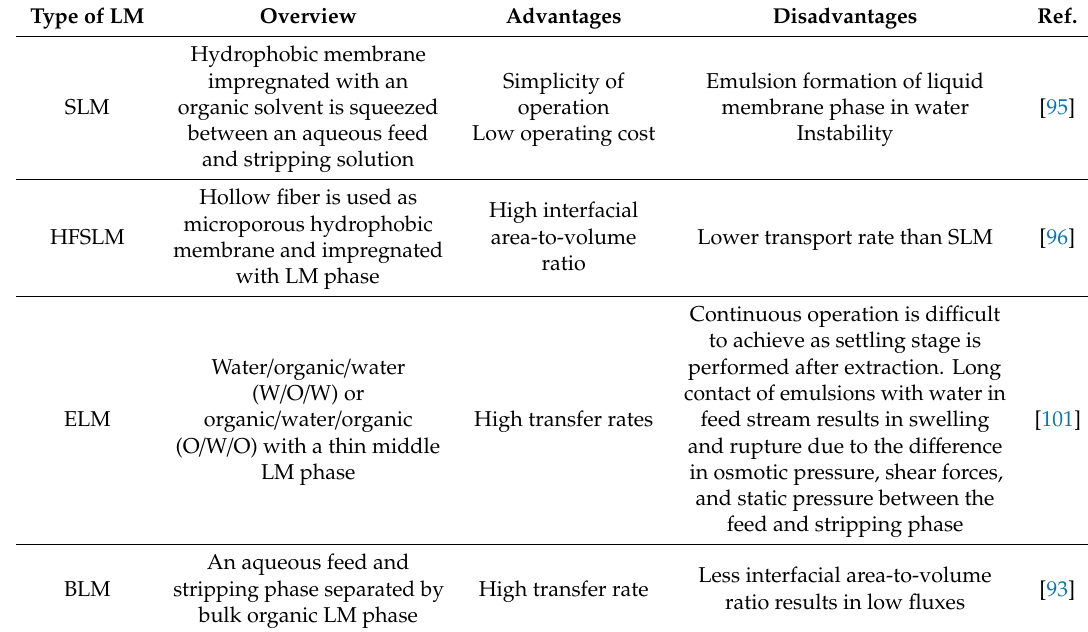
Table 3. Liquid membrane systems for metal ion